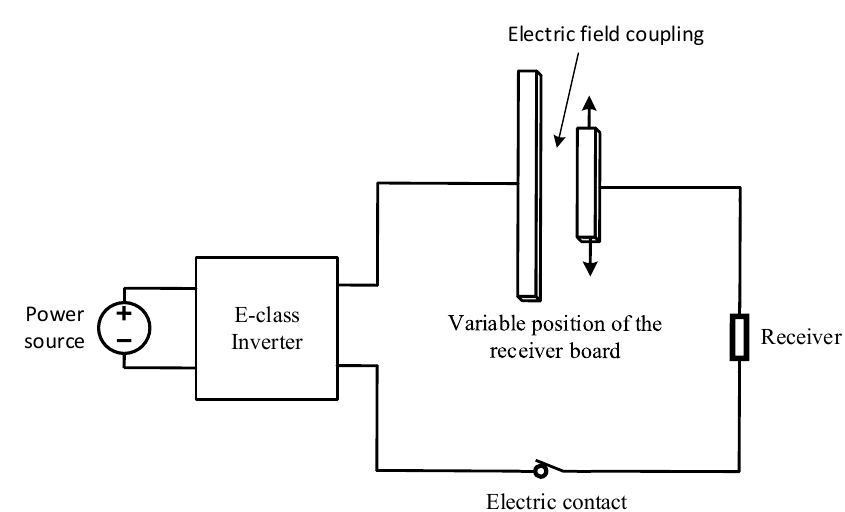
Figure 1. The configuration of elaborated capacitive power transmission (CPT) system.